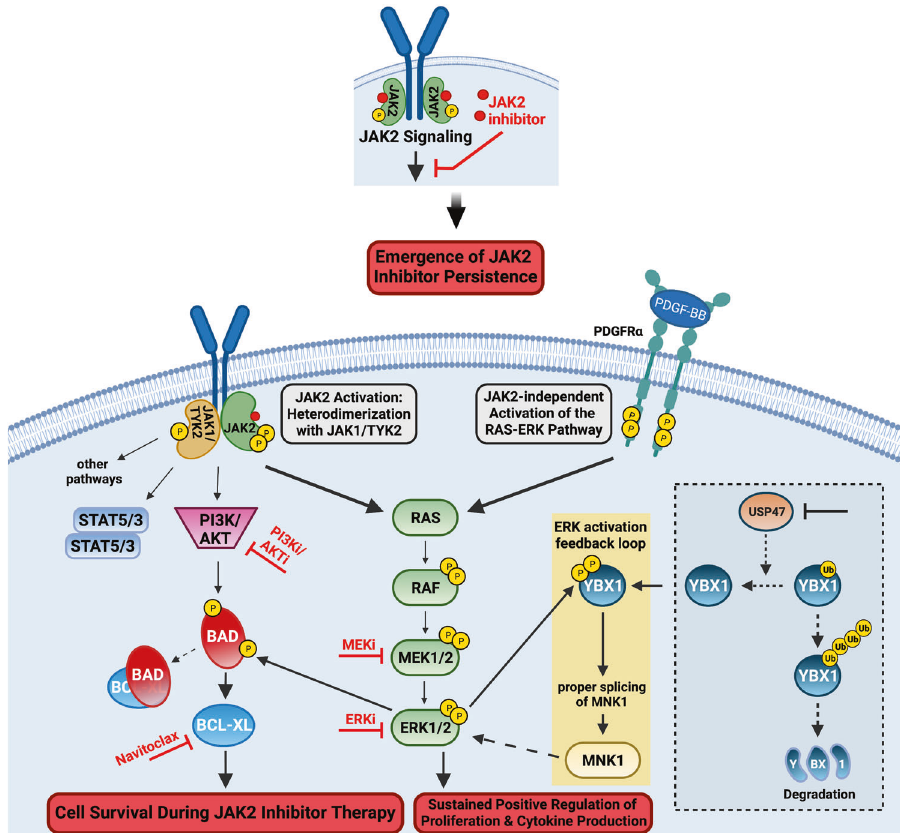
Fig. 1 Central Role of MEK/ERK activation in JAK2 inhibitor persistence in pre-clinical models of MPN. Multiple approaches have been used to uncover mechanisms of JAK2 inhibitor persistence in models of MPN, including JAK heterodimerization to reactivate JAK2 signaling [41], upregulation of PDGFR signaling as a JAK2-independent mechanism to activate ERK [65], and regulation of YBX1 function required to maintain ERK activation via splicing of MNK1 [64]. BAD inactivating phosphorylation by AKT as well as ERK prevents apoptosis in the presence of JAK2 inhibitors. MEK and ERK inhibition as well as BCX-XL inhibition (navitoclax) may antagonize ERK-dependent effects on cell survival to improve the ef fi cacy of JAK2 inhibitors. In analogy (shown by dashed box) to studies in imatinib resistance in CML, USP47 may control YBX1 protein levels [79], potentially providing a target to antagonize the role of YBX1 in JAK2 inhibitor